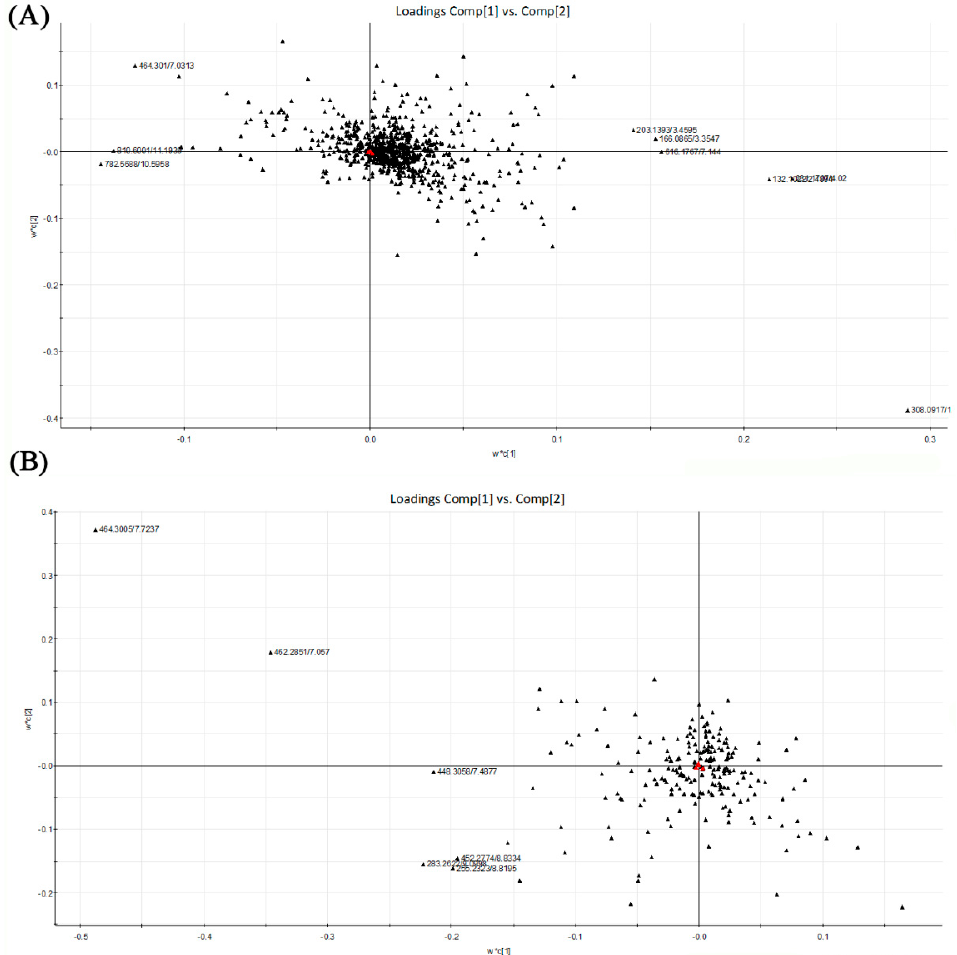
Figure 5. PLS-DA loading plots of the four tested groups from UPLC-Q-TOF-MS profiling data. Red triangles represent responses; Blacks represent X variables. ( A ) PLS-DA loading plot from positive ion mode; ( B ) PLS-DA loading plot from negative ion mode. PLS-DA, Partial least squares discriminant analysis; UPLC-Q-TOF-MS, Ultra-performance liquid chromatography-quadrupole-time-of-flight-mass spectrometry.